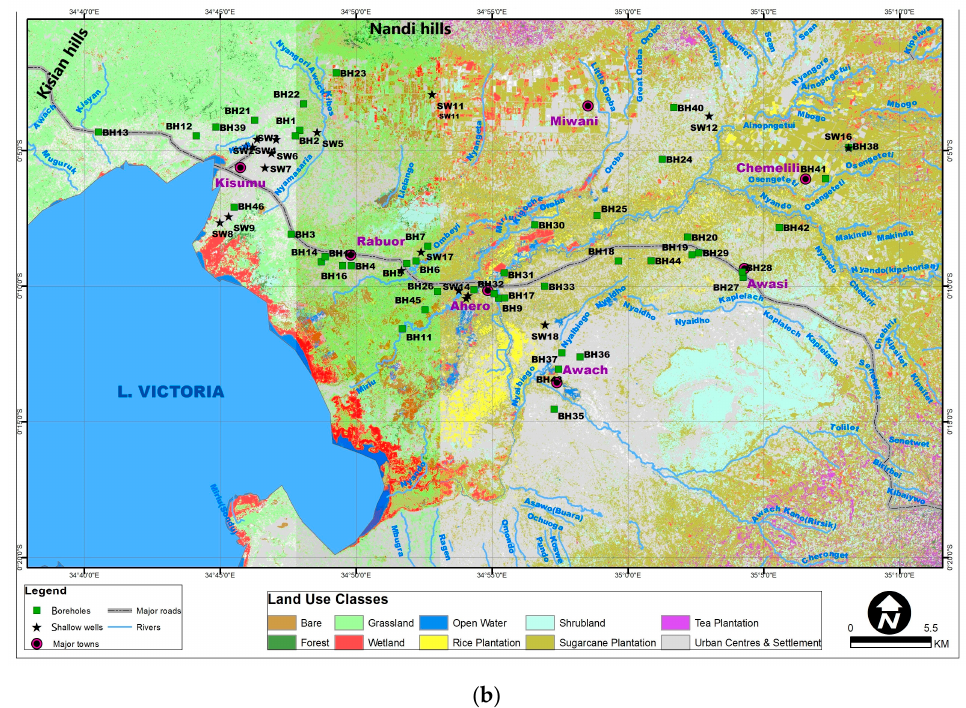
Figure 1. Study area map with an inset: location of the study area in the Lake Victoria basin, Kenya ( a ) and land use map indicating the spatial distribution of the groundwater sampling points represented by squares and stars for boreholes (BH) and shallow wells (SW), respectively ( b ).